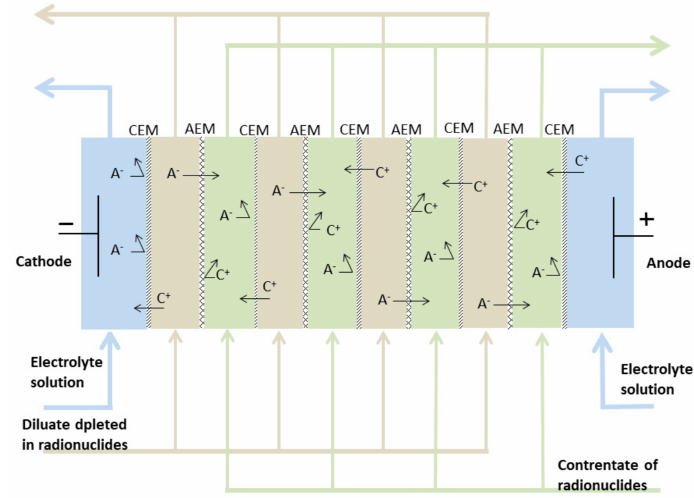
Figure 2. Scheme of membranes configuration in the ED cell.